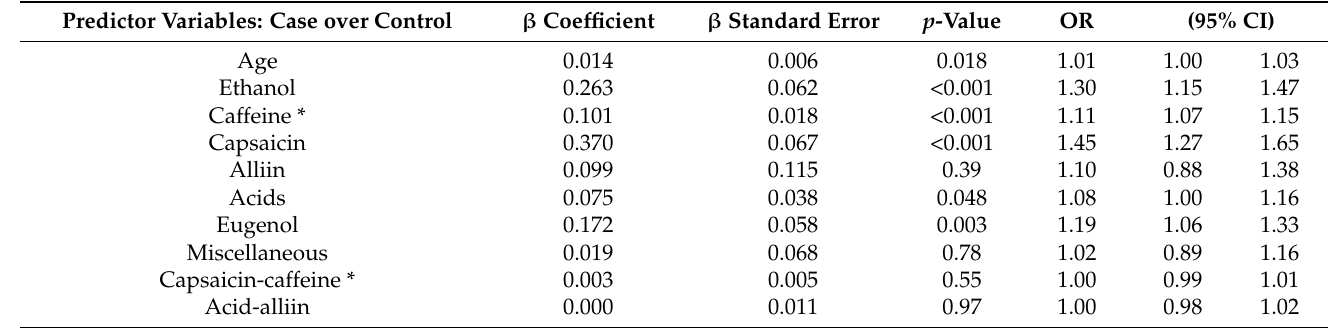
Table 5. Final model and interactions in predictive analysis of the influence of age and intake of plant food categories on the appearance of